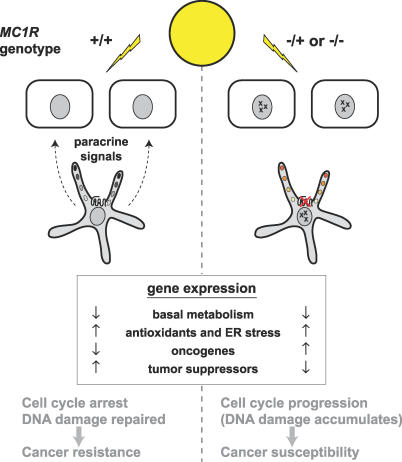
Model of MC1R-Dependent Protective Mechanisms against UVB Radiation in the Basal EpidermisUpon UVB-induced stress, the basal epidermis mounts a general protective response which is characterized by large-scale transcriptional repression of basal metabolic genes and induction of cell cycle and DNA-damage repair genes. Kit-dependent signals mediate the upregulation of antioxidant and ER stress-response genes. In homozygous wild-type MC1R individuals, paracrine factors released by melanocytes mediate cell cycle arrest in order to repair UVB-induced DNA damage (suppression and induction of oncogene and tumor suppressor gene expression, respectively). In contrast, partial or complete loss of MC1R function in the basal epidermis may predispose individuals to accumulating UVB-induced photolesions (x), through a diminished capacity of the basal epidermis to elicit an appropriate cell cycle arrest or DNA-damage repair [67] response (induction and suppression of oncogene and tumor suppressor gene expression, respectively), thereby rendering them susceptible to skin cancer.